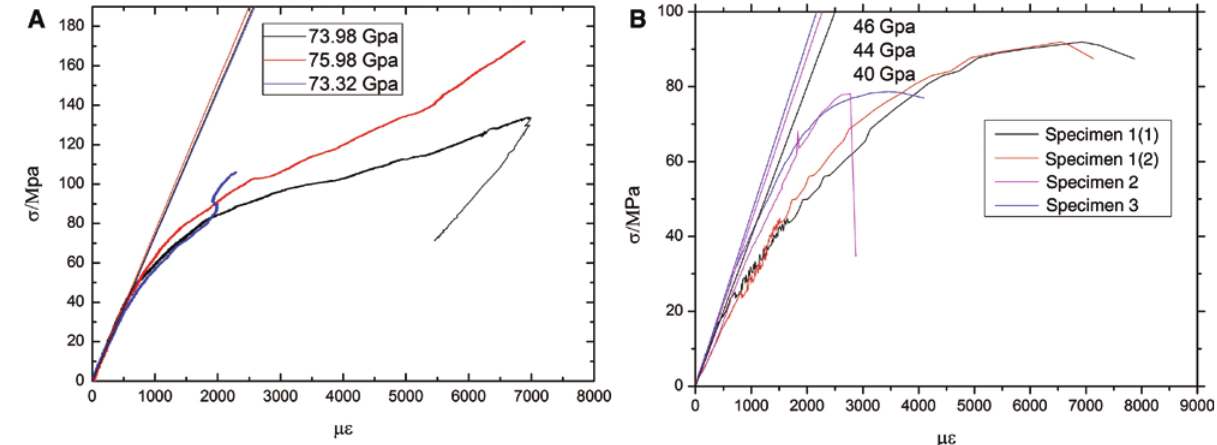
Figure 6: Experimental results of (A) the tensile test and (B) the shear test.